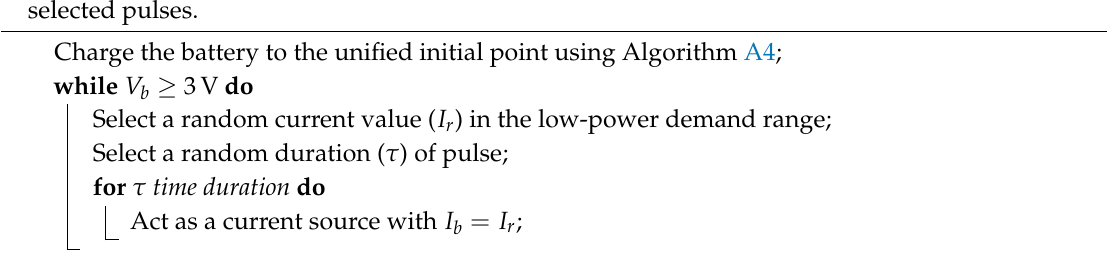
Algorithm A6: Procedure of collecting evaluation data by application of subsequent randomly selected